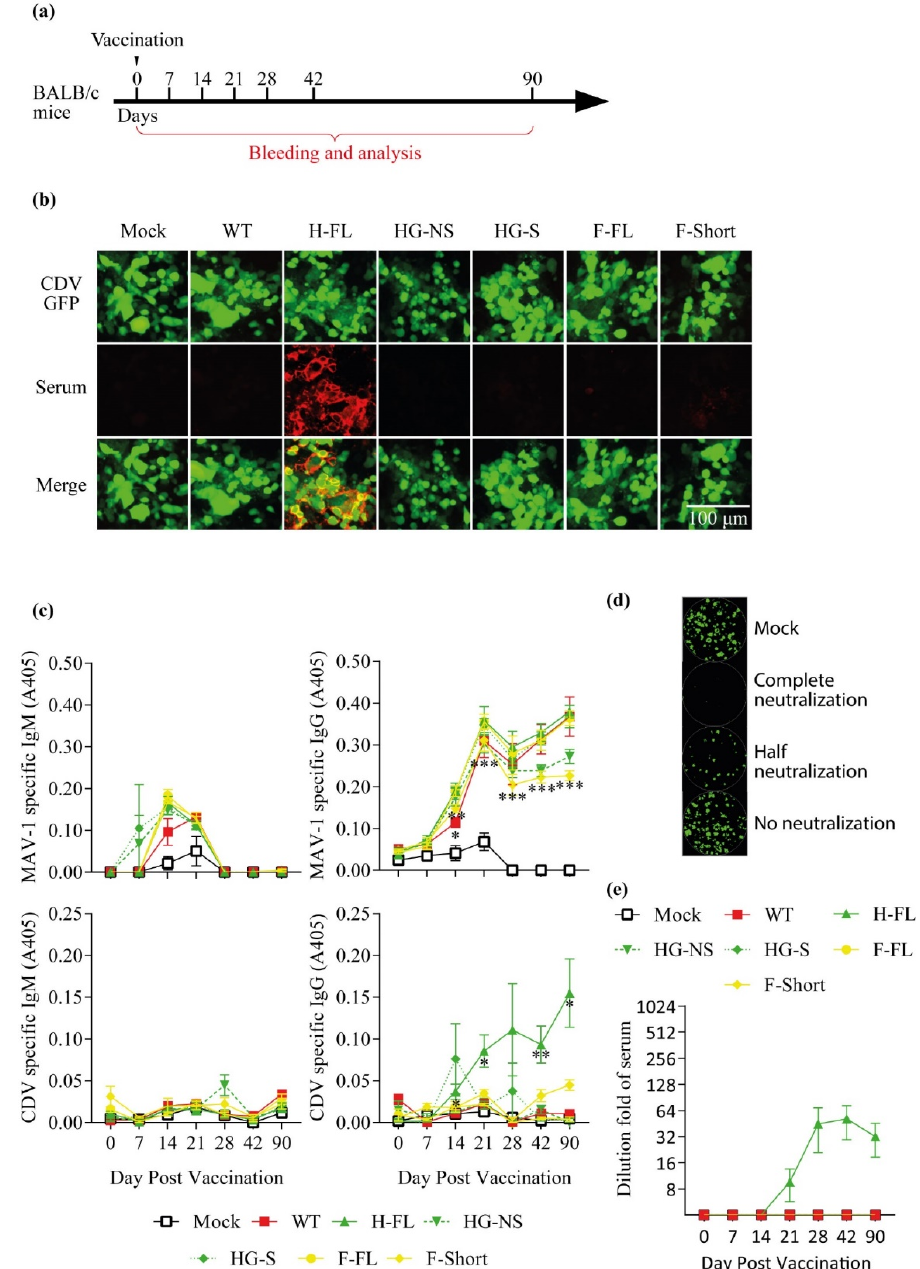
Figure 4. Characterization of the immune response induced by the MAV-1-based oral vaccines in BALB/c mice. ( a ) Design of the experiment. 8-week-old female BALB/c mice ( n = 5 mice/group) were orally immunized with 600 TCID50 of WT, H-FL, HG-NS, HG-S, F-FL or F-Short MAV-1 strains or with PBS as control (mock). Blood samples were collected at the indicated times p.i. ( b ) Detection of anti-CDV seroconversion by immunofluorescence performed on CDV-OndeGFP infected Vero cells with mice sera taken at 28 days post vaccination. Mouse antibodies were detected with Alexa 568 goat anti-mouse polyserum. ( c ) MAV-1 and CDV specific IgG and Ig measured over time in mouse serum as described in the methods. The data presented are the means for 5 mice ± SEM. p values are relative to comparison with the mock group. *, p < 0.05, **, p < 0.01, ***, p < 0.001. ( d ) Representative images of the neutralizing effect. The mock condition represents treatment with serum of non-vaccinated mice. ( e ) CDV-neutralizing antibody titres measured over time in mouse serum as described in the methods. The data presented are the means for 5 mice ± SEM.